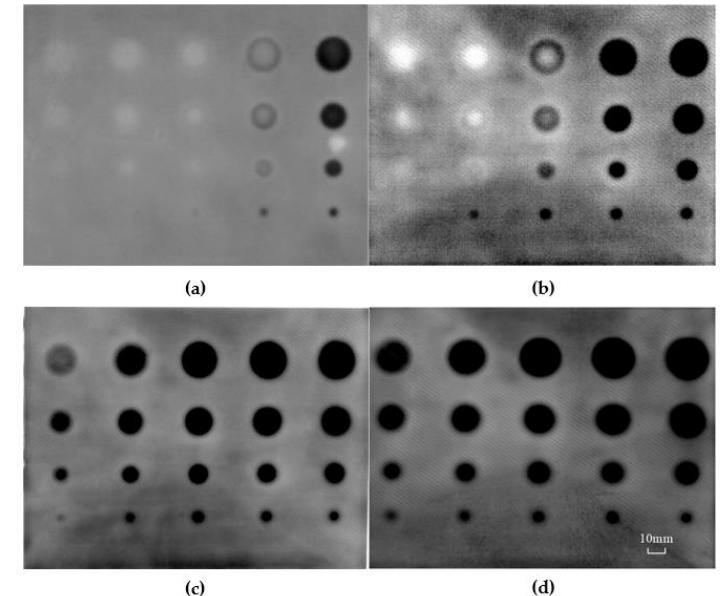
Figure 6. Detected images with varied image sampling rate in the GFRP panel. ( a ) 1 Hz; ( b ) 5 Hz; ( c ) 10 Hz; ( d ) 30 Hz.